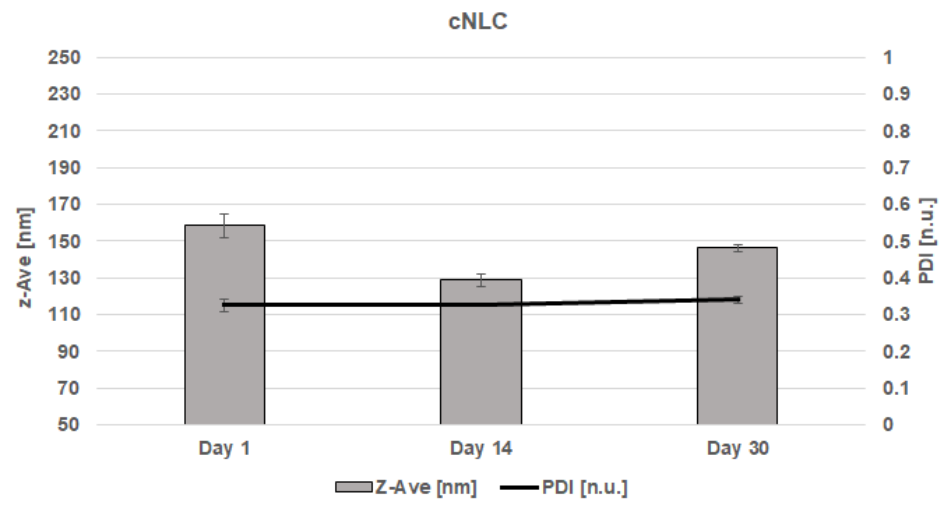
Figure 3. Z-Ave and PDI for CBD-cNLC on the 1, 14, and 30 days after the production.